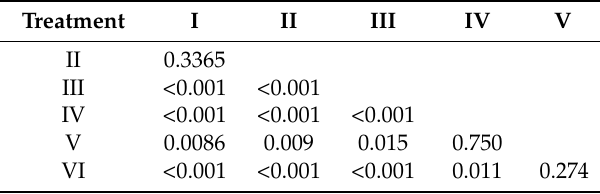
Table 2. Pairwise t -tests of the black locust seed germination by (I) directly sowing, (II) 24 h soaking, (III) warm-cold treatment for two hours at 45 ◦ C and two hours at − 20 ◦ C, (IV) warm-cold treatment